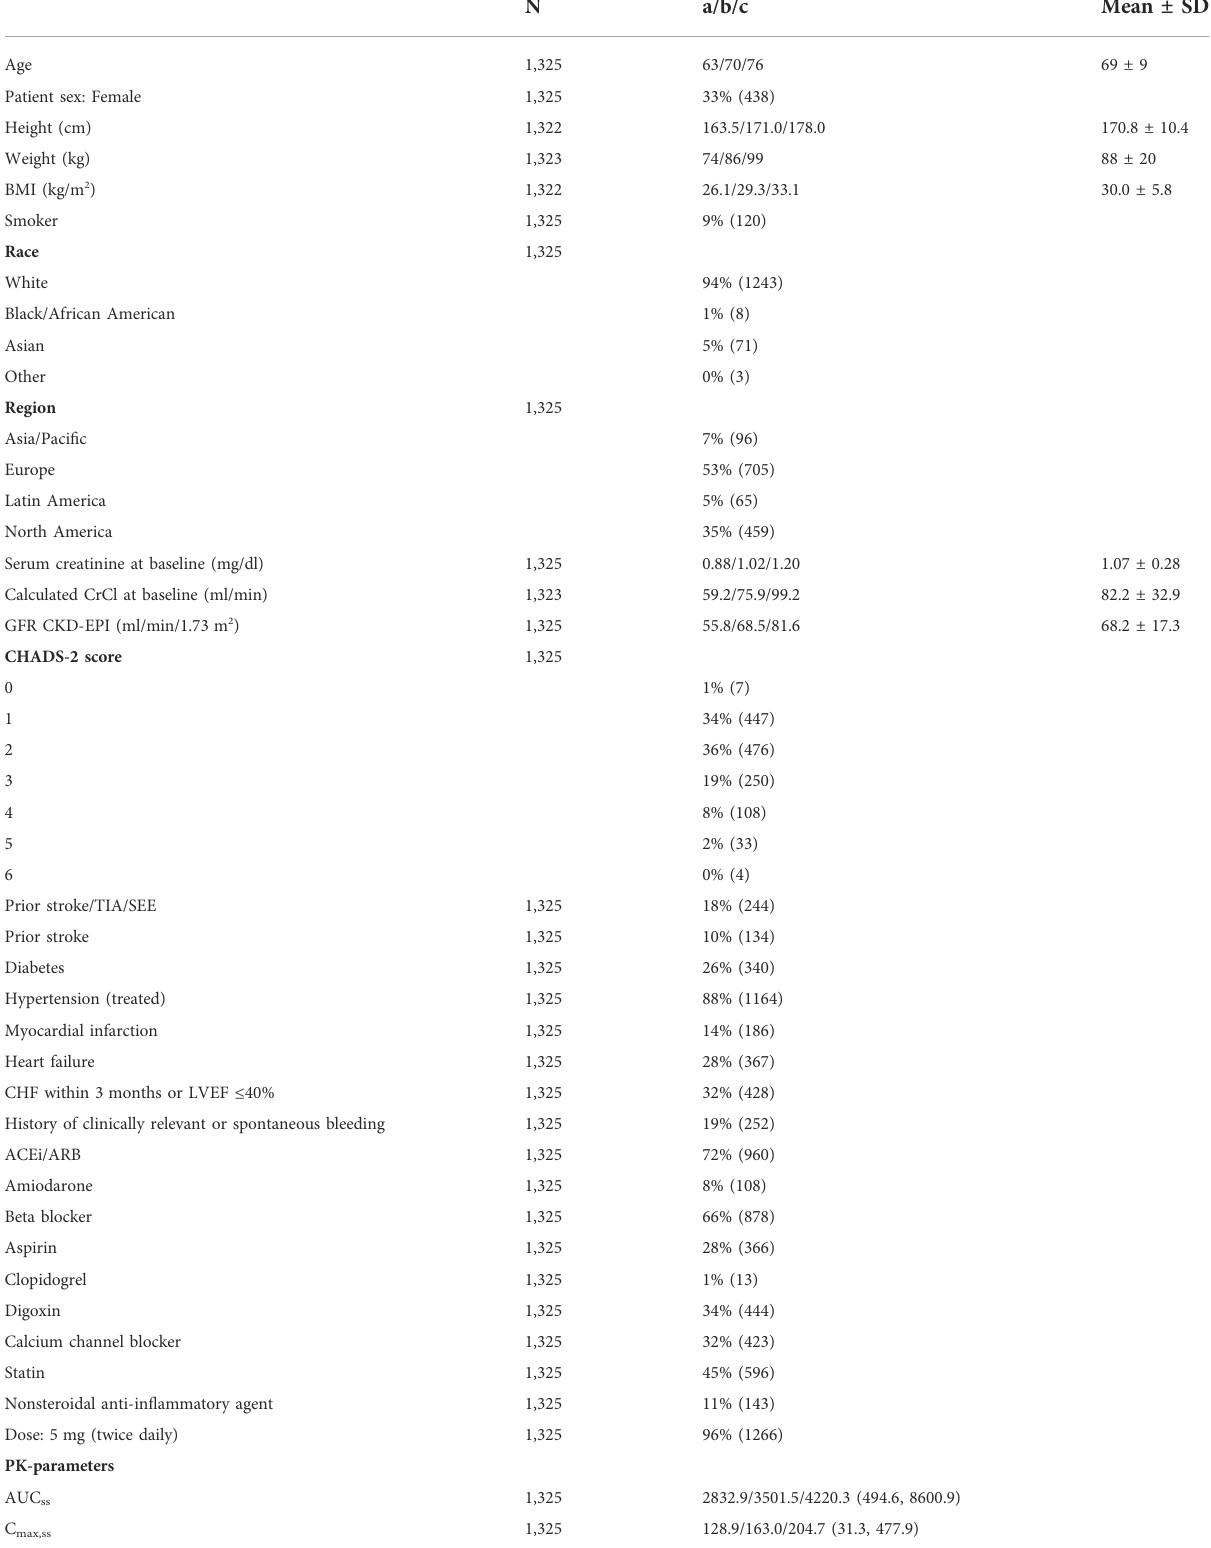
TABLE 1 Characteristics for apixaban-treated patients with data from both whole-genome scans and pharmacokinetic